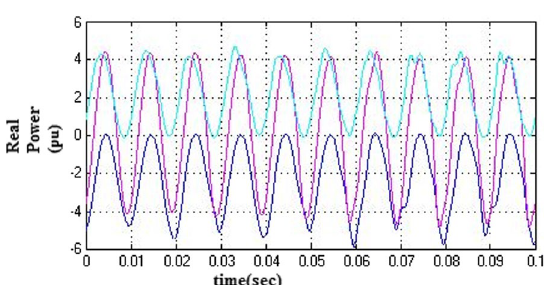
Fig. 22 Real power flow at bus 7 without STATCOM of IEEE 9- bus